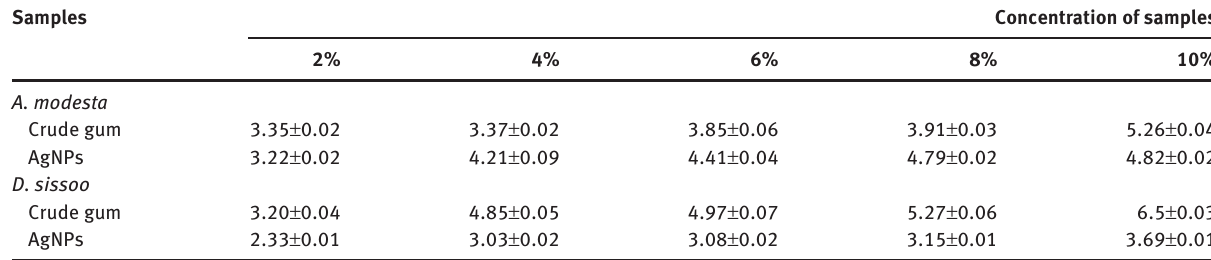
Table 3: Hemolytic activity of gum-based AgNPs.